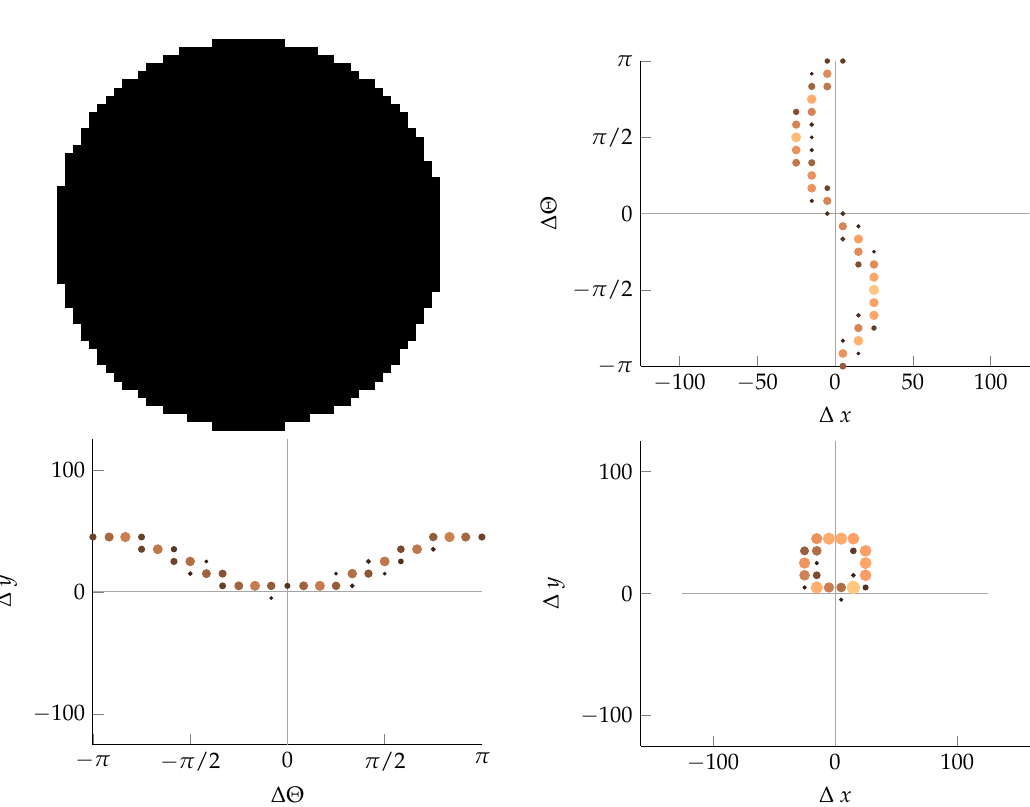
Figure B2. Geometry example